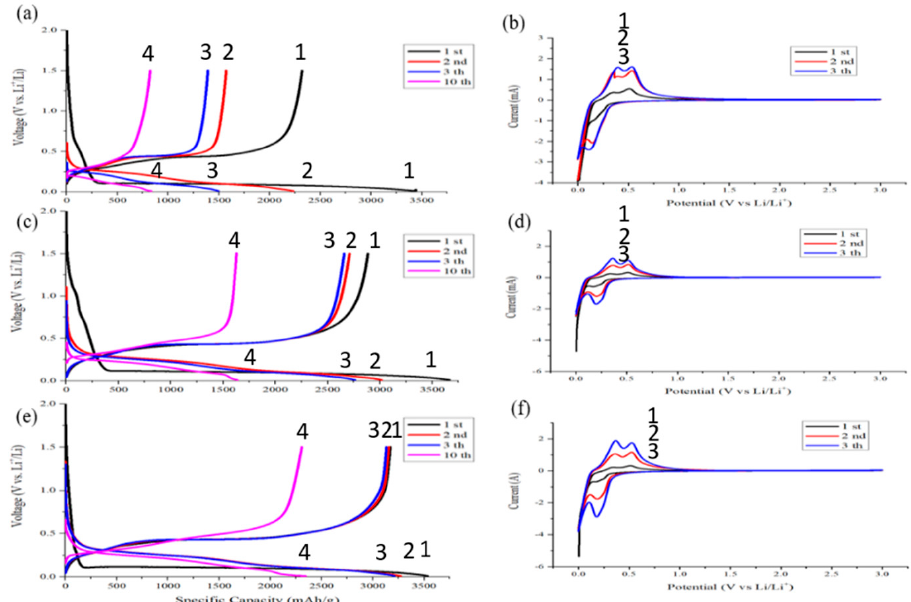
Figure 11. Cyclic Voltammetry measurements of anodes made of ( a , b ) silicon flakes: KB–CMC/SBR = 70%:10%:20% in weight ratio, ( c , d ) silicon flakes–KB–CMC/SBR = 70%:10%:20% in weight ratio after pyrolysis, and ( e , f ) silicon flakes–CMC/SBR = 70%:30% in weight ratio after pyrolysis. The scan rate is 0.1 mV/s. The discharge–charge rate for ( b , d , f ) is 200 mA/g for first three cycles and 1000 mA/g for the remaining